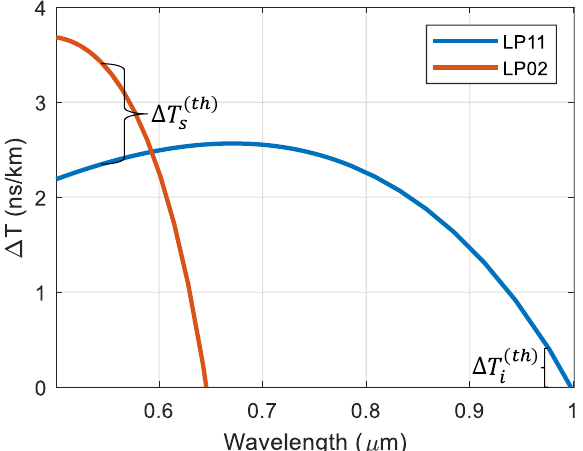
Fig. 3 Numerical computation of the modal delays of the LP 11 (blue curve) and the LP 02 (red curve) modes. The delays are presented relative to the fundamental mode LP 01 , to compensate for the chromatic delay. For the signal photon at λ s = 542 nm, the delay between the LP 02 and LP 11 modes is Δ T ð th Þ s ¼ 1ns = km , in agreement with the experimentally measured delays presented in Fig. 2c. For the idler photon at λ i = 970 nm, the delay between the LP 11 and LP 01 ¼ 0 : 5ns = km , in agreement with measured delays modes is Δ T ð th Þ i reported in Fig.